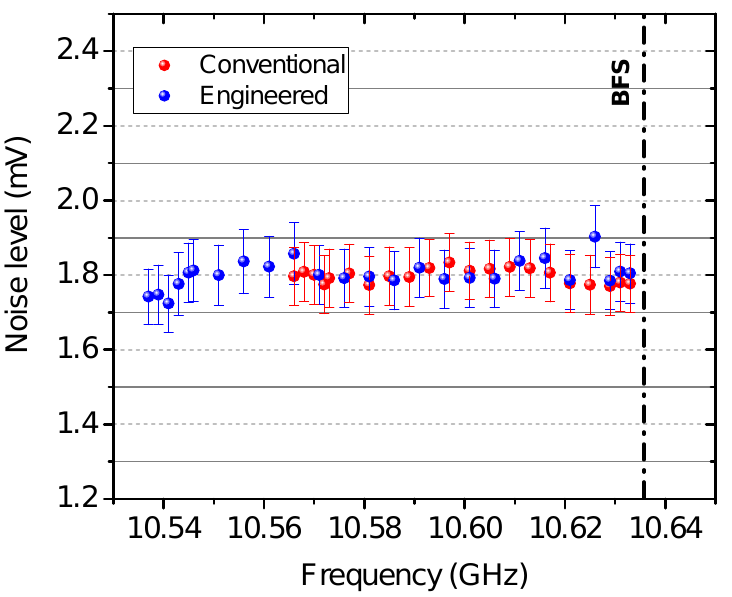
Figure 14. Noise level of the detected trace baseline as a function of the interrogation frequency for dynamic sensing.